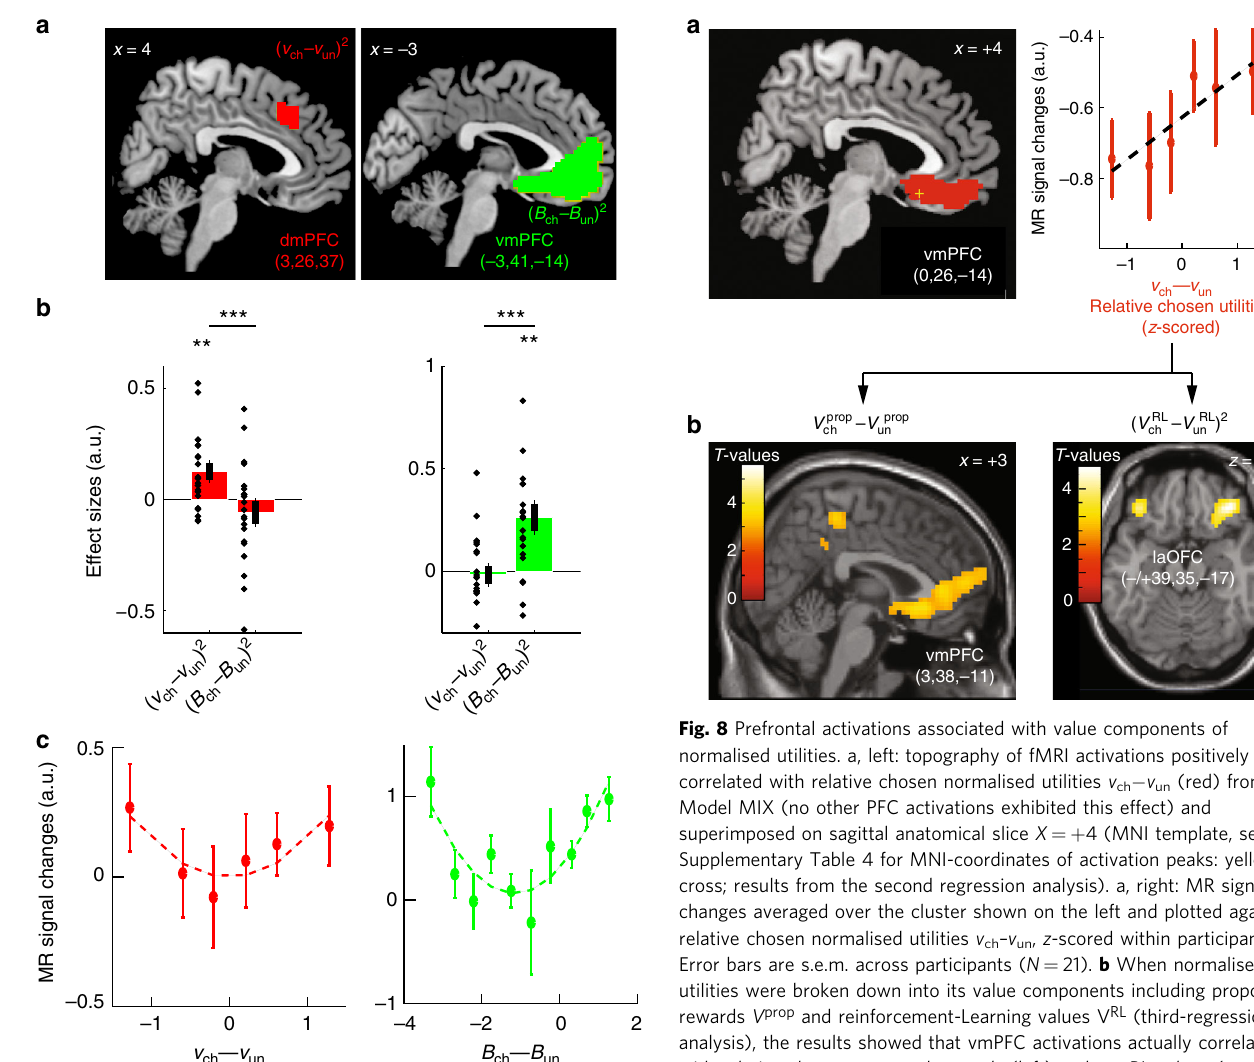
Table 5 for MNI-coordinates of activation peaks